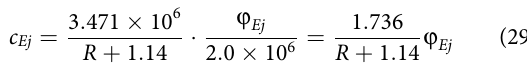
in proportion to { ϕ Ej }. In each story, c Ej is assumed to be propor- tional to ϕ Ej , and is given by Eq. 6 with the design parameters